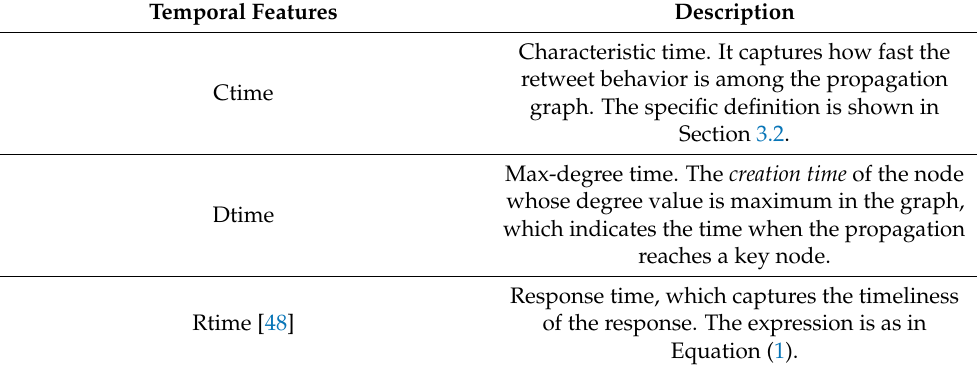
Table 3. Structural